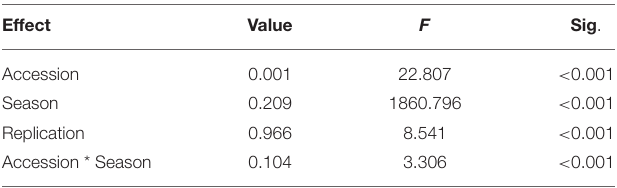
TABLE 4 | Multivariate analysis of variance (MANOVA) to study seasonal differences in quantitative traits. Effect